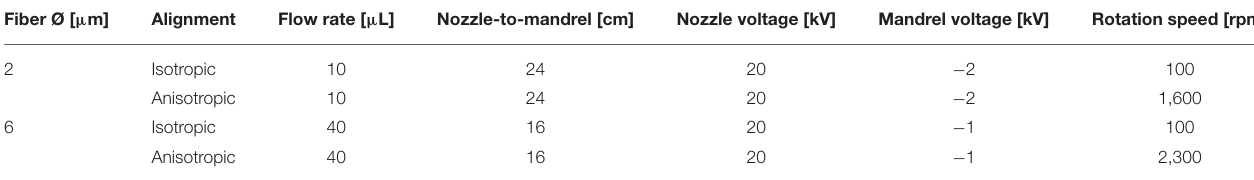
TABLE 1 | Electrospinning settings for the different scaffold